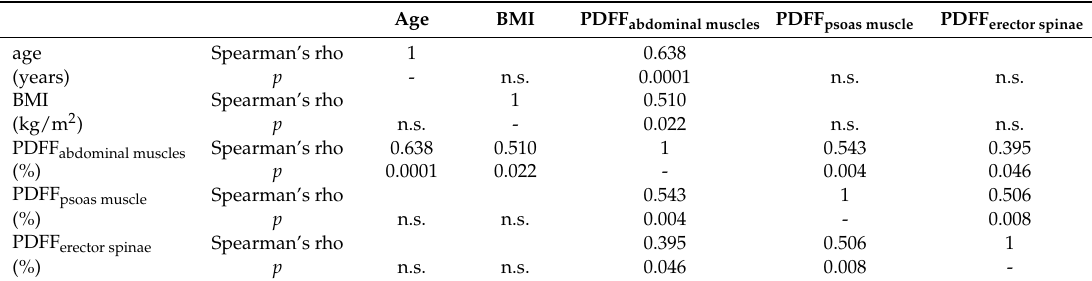
Table 2. This table illustrates the results of the correlation of age, body mass index (BMI), and proton density fat fraction (PDFF) in the abdominal muscles, psoas muscle, and erector spinae in men. Spearman’s rho correlation coefficients are provided for each correlation, and p -values indicate statistical significance of the respective correlation (n.s.: not significant).